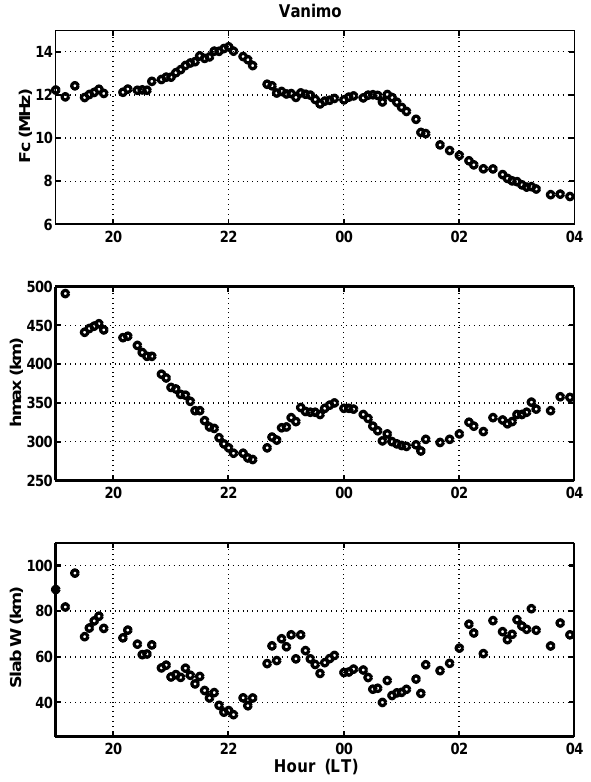
Fig. 8. Ionospheric critical frequency Fc , peak height hm F2 and sub-peak slab width W observed at Vanimo on 24 February 1999 showing multiple similar